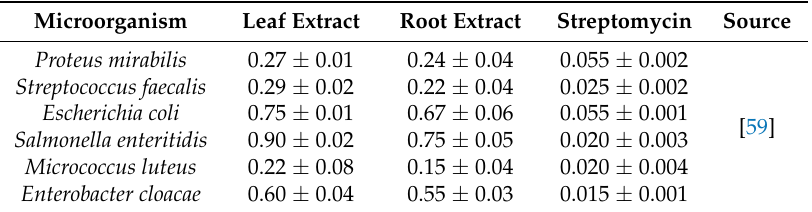
Table 5. Antimicrobial activity of G. kurroo extracts (minimal inhibitory concentration (MIC) value expressed in mg/mL).